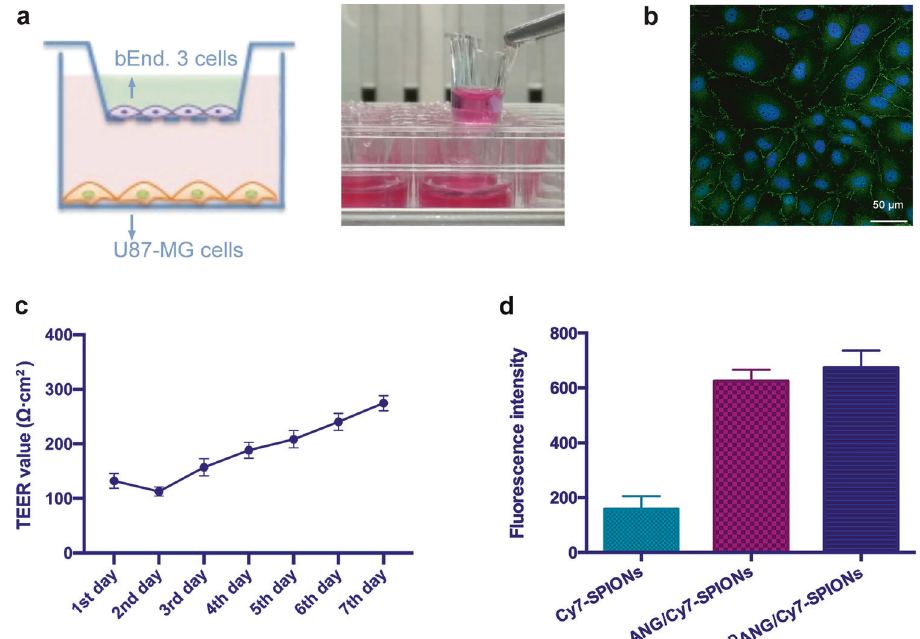
Fig. 5 a Schematic of the in vitro BBB model by Transwell assays; b Immuno fl uorescence staining of the endothelial cell interstitial protein ZO- 1 (green); nuclei (blue); c TEER value of the in vitro BBB model for 7 consecutive days; d The fl uorescence intensities of the Cy7-SPIONs, ANG/ Cy7-SPIONs, and D ANG/Cy7-SPIONs probe solutions passing through the upper chamber of the Transwell unit. Data from at least three independent experiments are shown as the means ± SEMs, n =